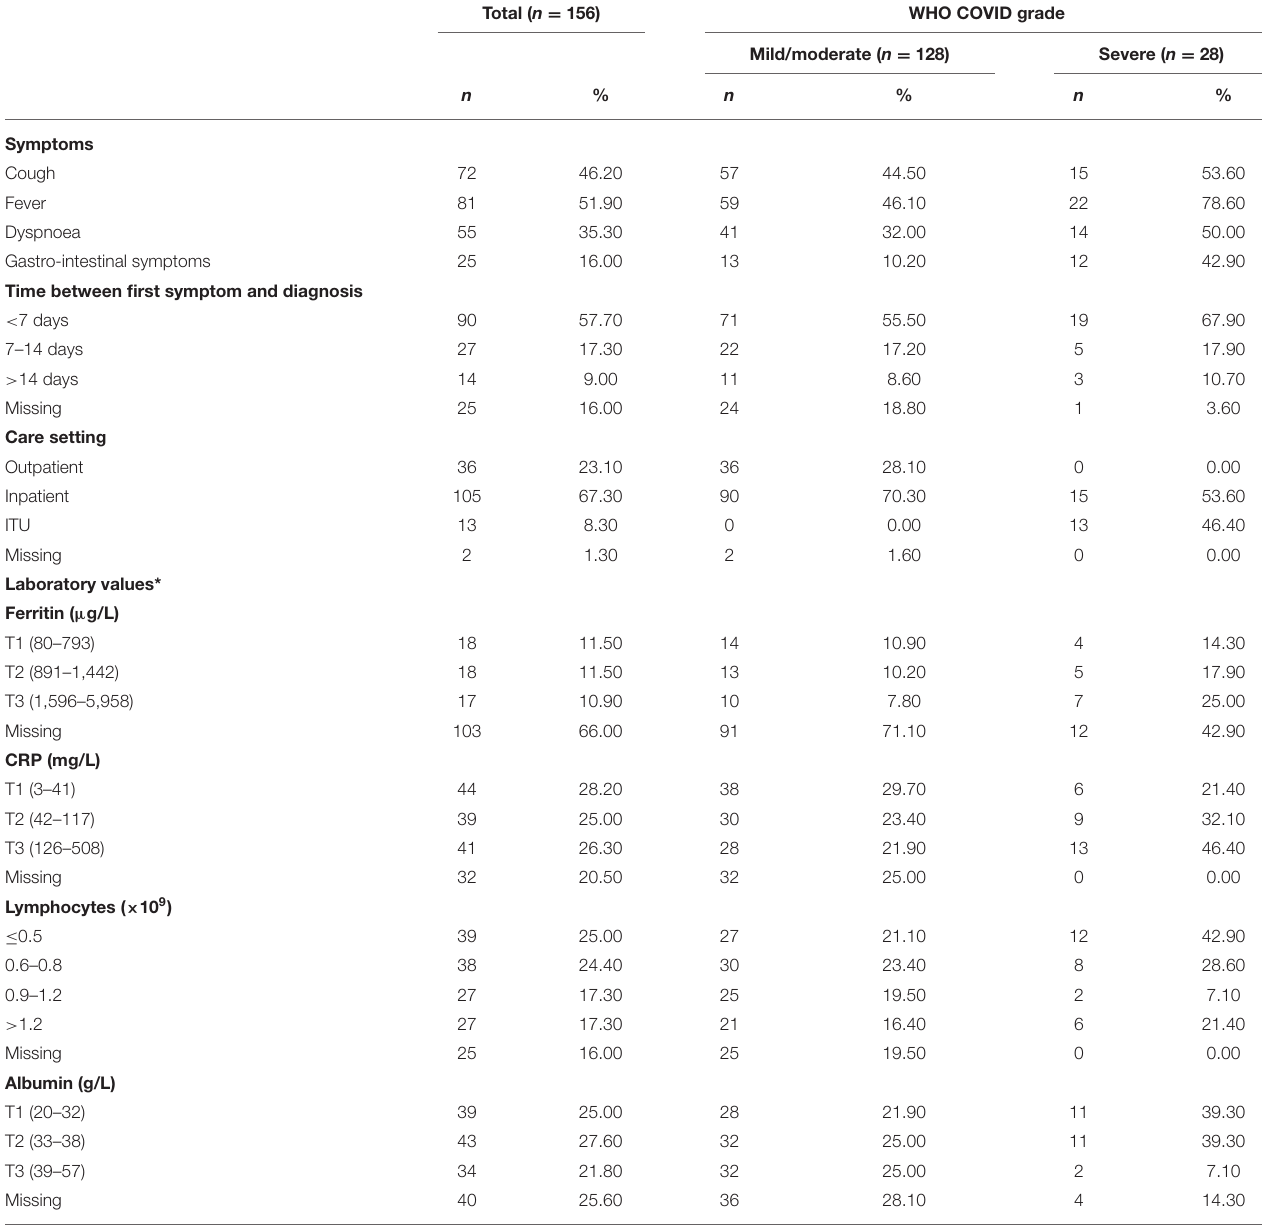
TABLE 3 | COVID-19 presentation of COVID-19 positive cancer